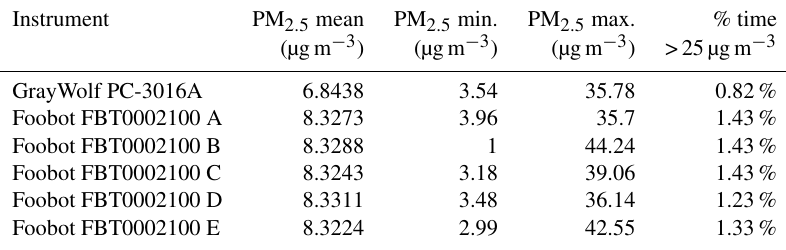
Figure 6. Carbon dioxide levels from 29 August to 1 September 2017 form the Foobot and GrayWolf instruments. (Activity describes the morning routine: showering, grooming, and changing.) Table 5. Summary statistics for PM 2 . 5 calibration dataset divided by instruments.